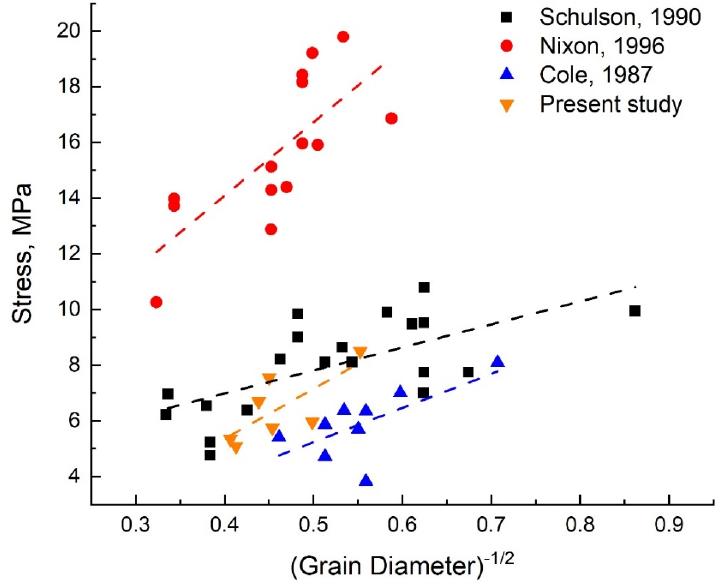
Figure 12. Stress versus grain size (data from Schulson (1990) [26], Nixon (1996) [44], Cole (1987) [28] and present study) and fitted curves. Table 5. Regression and correlation coefficients for stress vs. grain size fitting function.